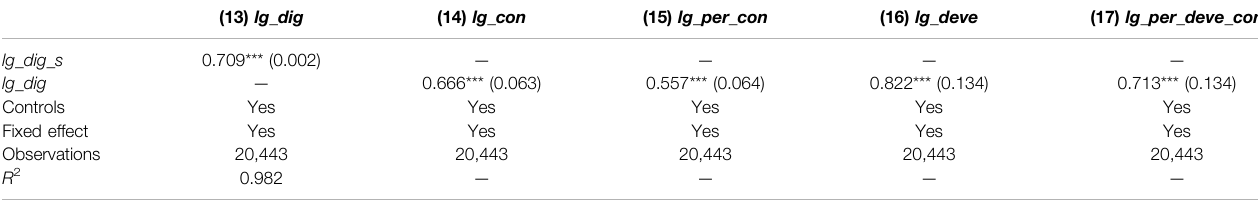
TABLE 4 | Robustness checks: Instrumental Variable method.